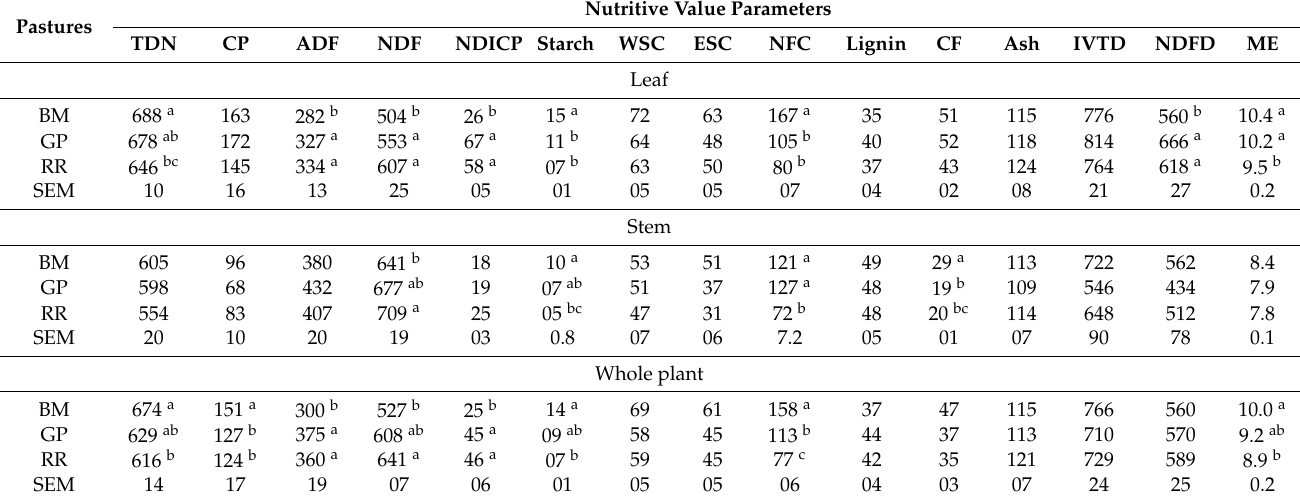
Table 5. Effect of pasture species on the nutritive value measured in leaf and stem fractions of five harvests at Gatton Research Dairy, Queensland, Australia from November 2020 to May 2021. Crude protein (CP), acid detergent fibre (ADF), neutral detergent fibre (NDF), neutral detergent insoluble protein (NDICP), water-soluble carbohydrates (WSC), nonfibre carbohydrates (NFC), crude fat (CF), ethanol-soluble carbohydrates (ESC) total digestible nutrients (TDN), in vitro true digestibility 24 h (IVTD), in vitro NDF digestibility 24 h as % of NDF (NDFD) are presented as g kg − 1 . Metabolisable energy (ME) is given in MJ kg − 1 DM. Brachiaria Mulato II (BM), Gatton panic (GP), Rhodes grass Reclaimer